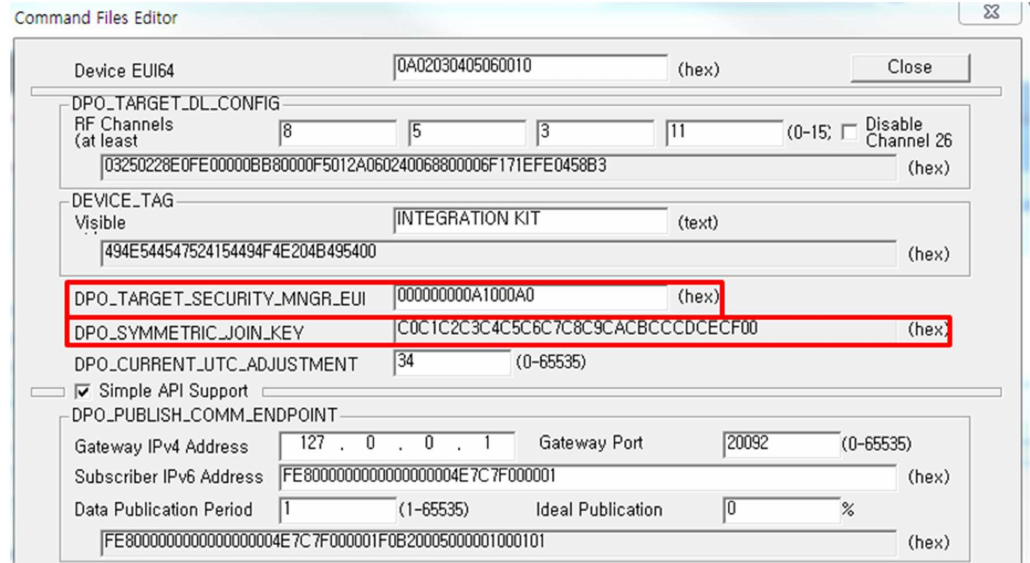
Figure 4. Configuration tool for the USB wireless provisioning device. The two red-boxed contents show the EUI-64 address of the security manager and the join